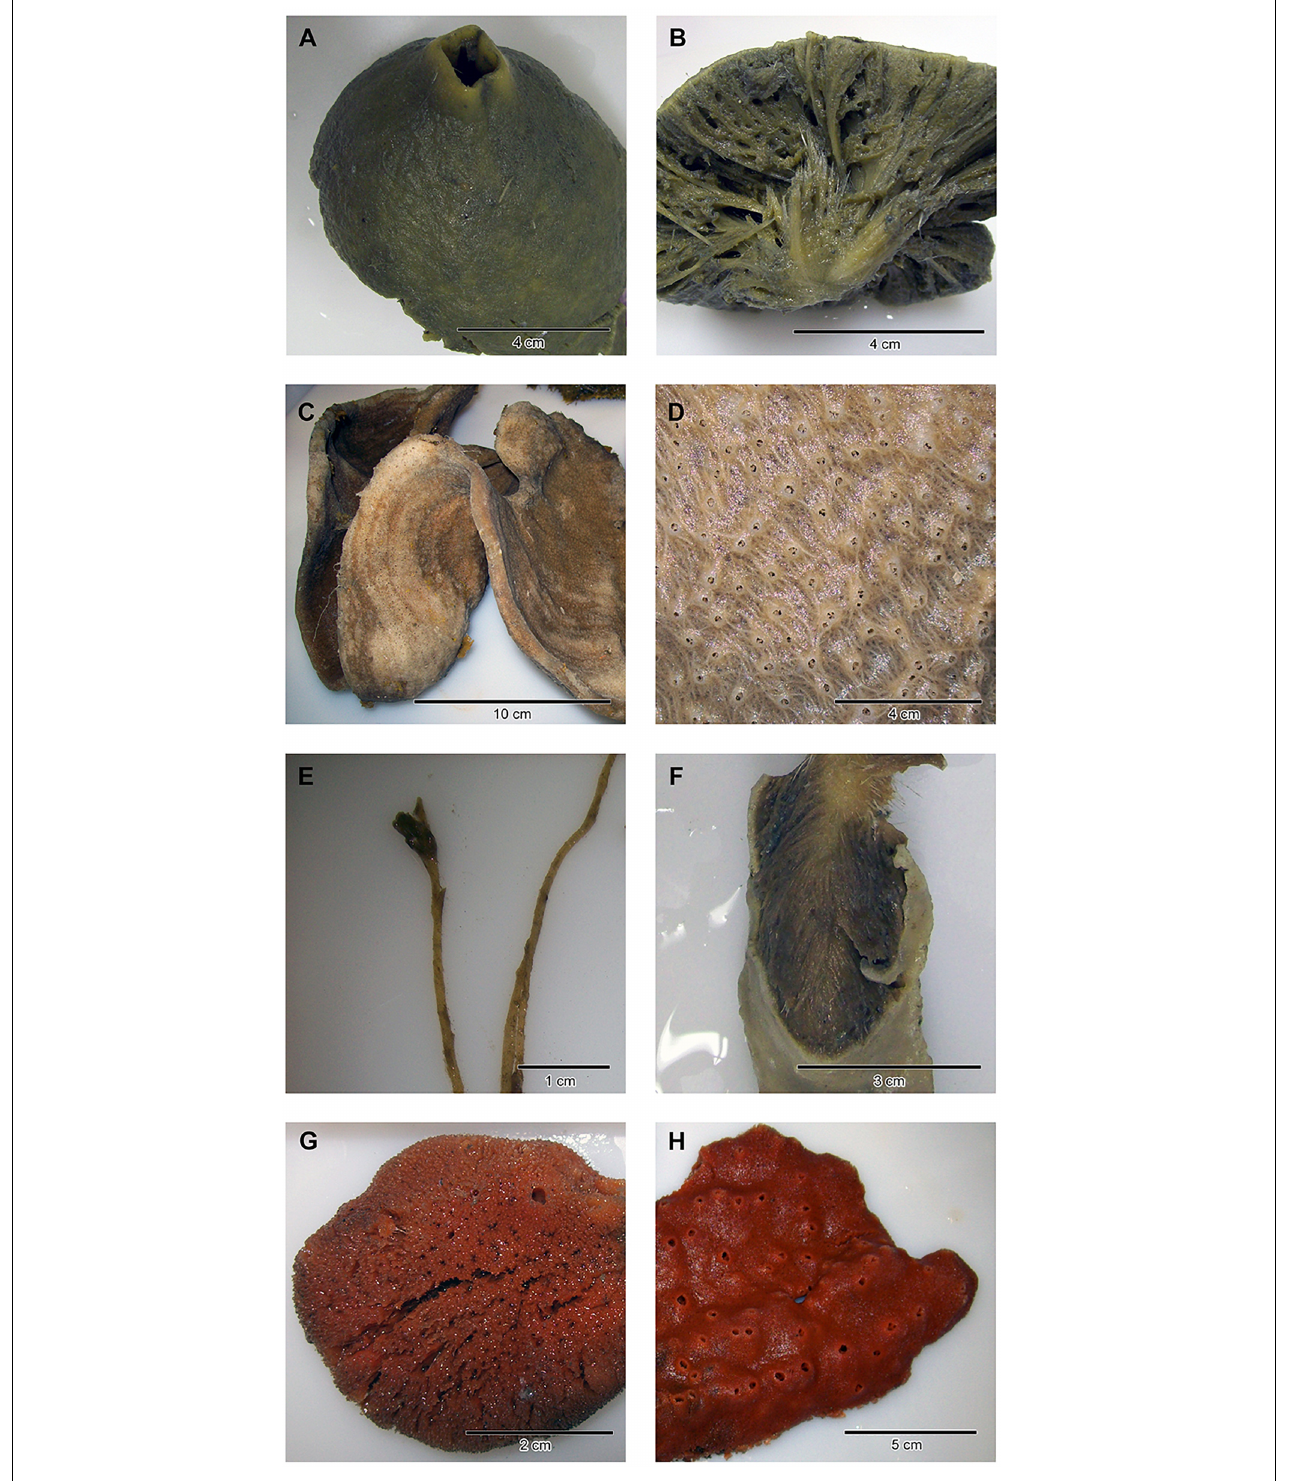
FIGURE 1 | Close-ups and/or dissections of representatives of the four sponge taxa analyzed in the present study: (A,B) Antarctotetilla leptoderma (C,D) Haliclona sp. (E,F) Homaxinella balfourensis , and (G,H) Isodictya bentarti .